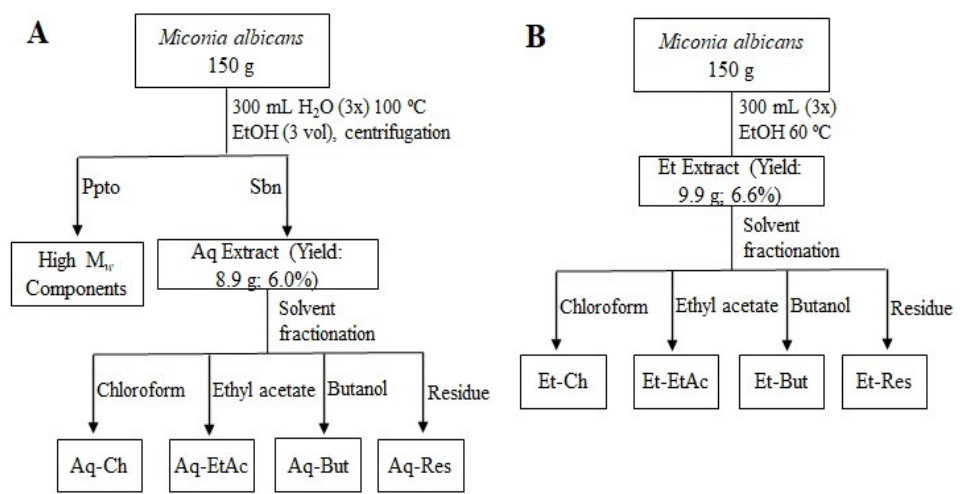
Figure 1. Extraction and fractionation scheme of M. albicans by aqueous ( A ) and ethanol ( B ) extraction.